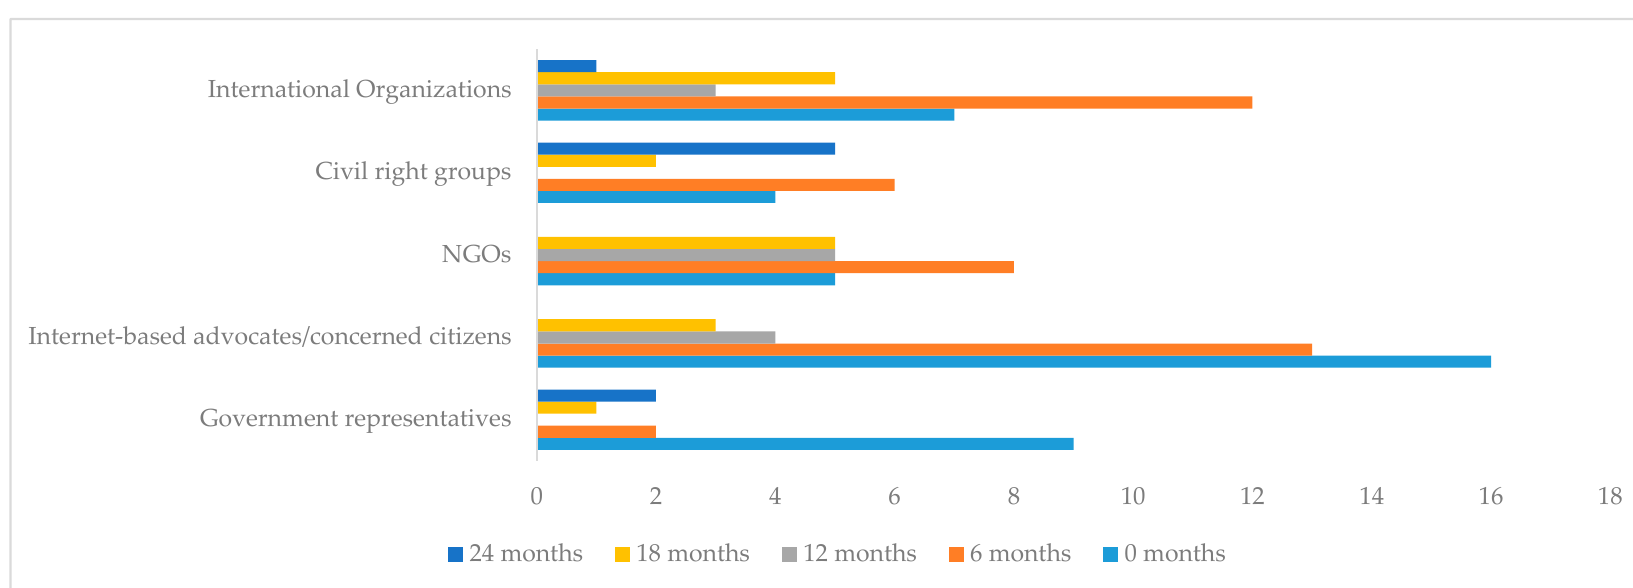
Figure A3. Distribution of respondents in Niger.